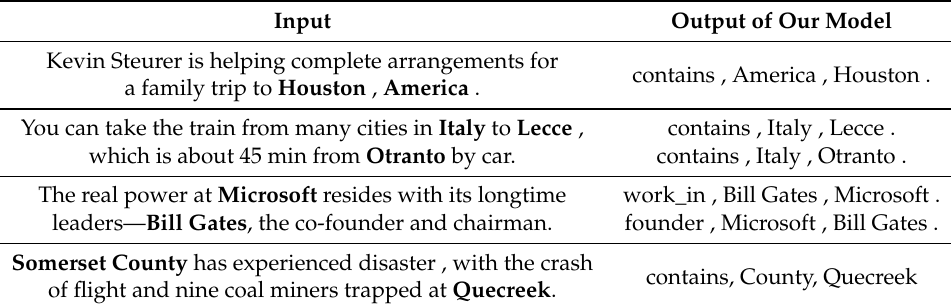
Table 5. Extraction examples of our models. The first column in the table is the input of the model, and the second column is the corresponding sentences of the output of the model. As described in Section 3.1 above, multiple relational triples in the model output are separated by ‘.’ and ‘,’ separates relational words and two entities within each